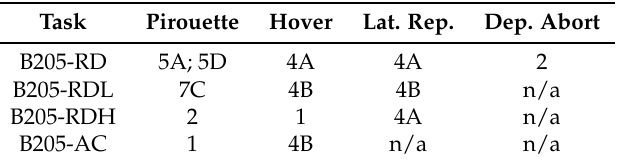
Table 6. APCRs awarded.